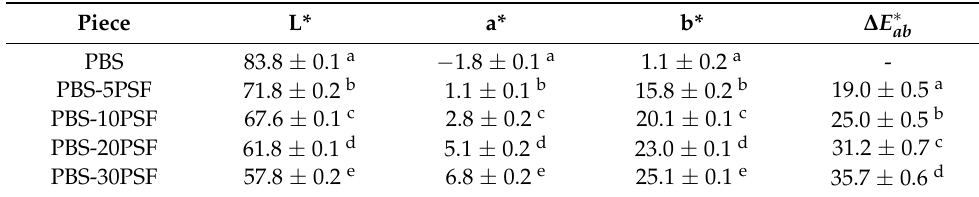
Table 1. Luminance (L*), color coordinates (a*b*), and color difference ( ∆ E ∗ molded pieces of poly(butylene succinate) (PBS)/pistachio shell flour (PSF) compatibilized with poly(butylene succinate) grafted with maleic anhydride (PBS- g -MAH).